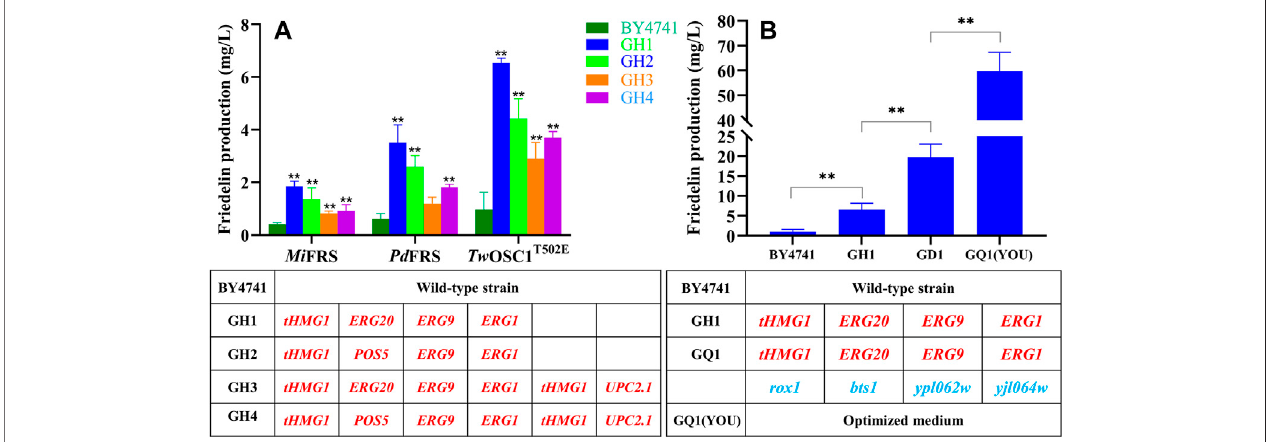
FIGURE 3 | Comparison of the yield of FRSs from different plant sources and the transformation process of the dominant strain GQ1. (A) The comparison chart of the yield of friedelin obtained by introducing three FRSs into the recombinant strain GH1, GH2, GH3, GH4, respectively. The asterisk shows a statistical signi fi cance between engineered strains and wild-type strain BY4741. (B) Diagram ofthe transformation process ofthe dominant strain GQ1, (YOU) representsthe use ofoptimized medium for cultivation. The asterisk shows a statistical signi fi cance between engineered strains (* p < 0.05, ** p < 0.01). In the table below, uppercase red indicates overexpressed genes, and the lowercase blue indicates knocked out genes.